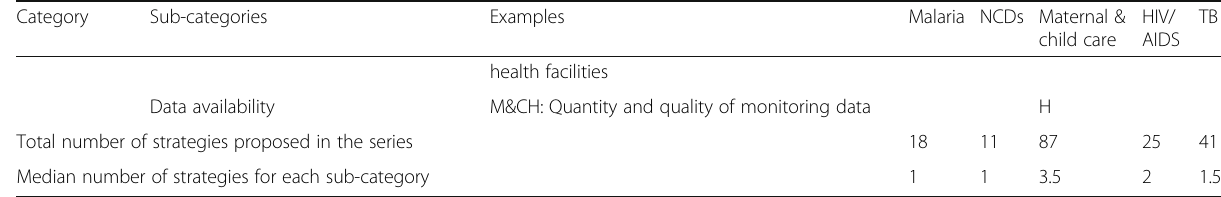
Table 3 Categories, sub-categories and examples from the Lancet series (Continued)